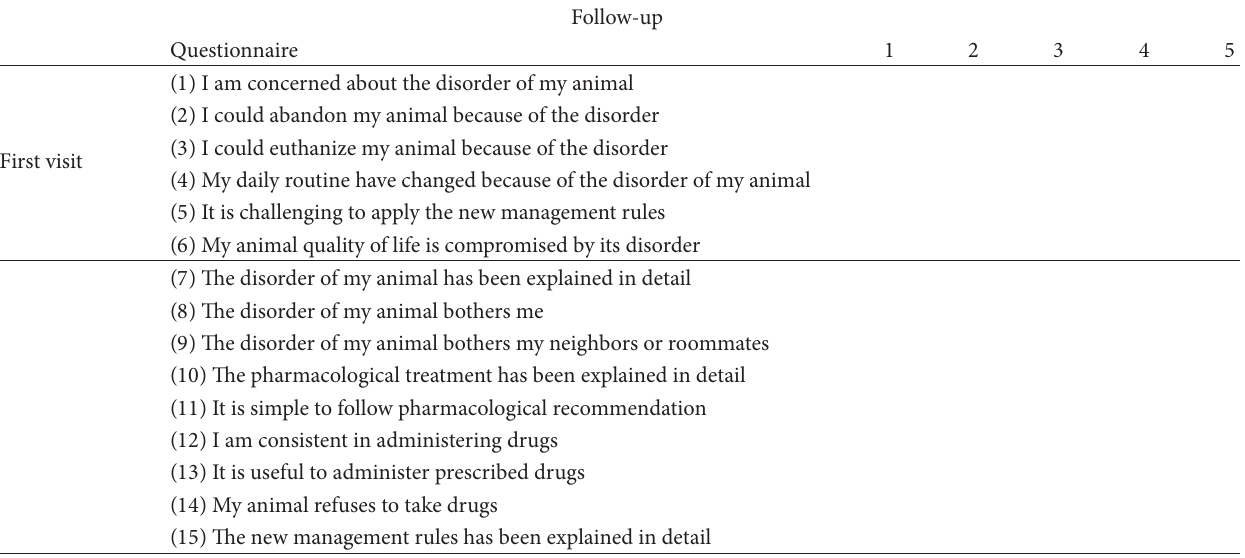
Table 1: Questionnaire: 1 = strongly disagree; 2 = disagree; 3 = neither; 4 = agree; and 5 = strongly